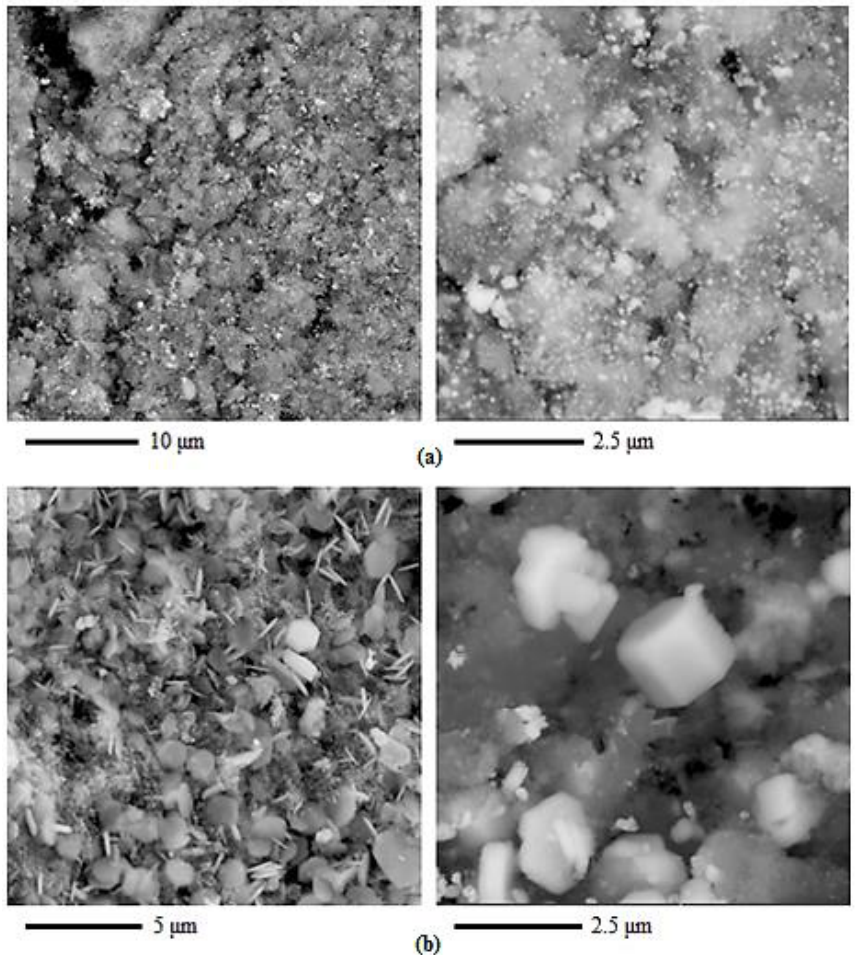
Figure 6. SEM images of AFP + Co(NO 3 ) 2 (700 °C) composite ( a ) after HT and ( b ) after APh electro- hydrogenation.